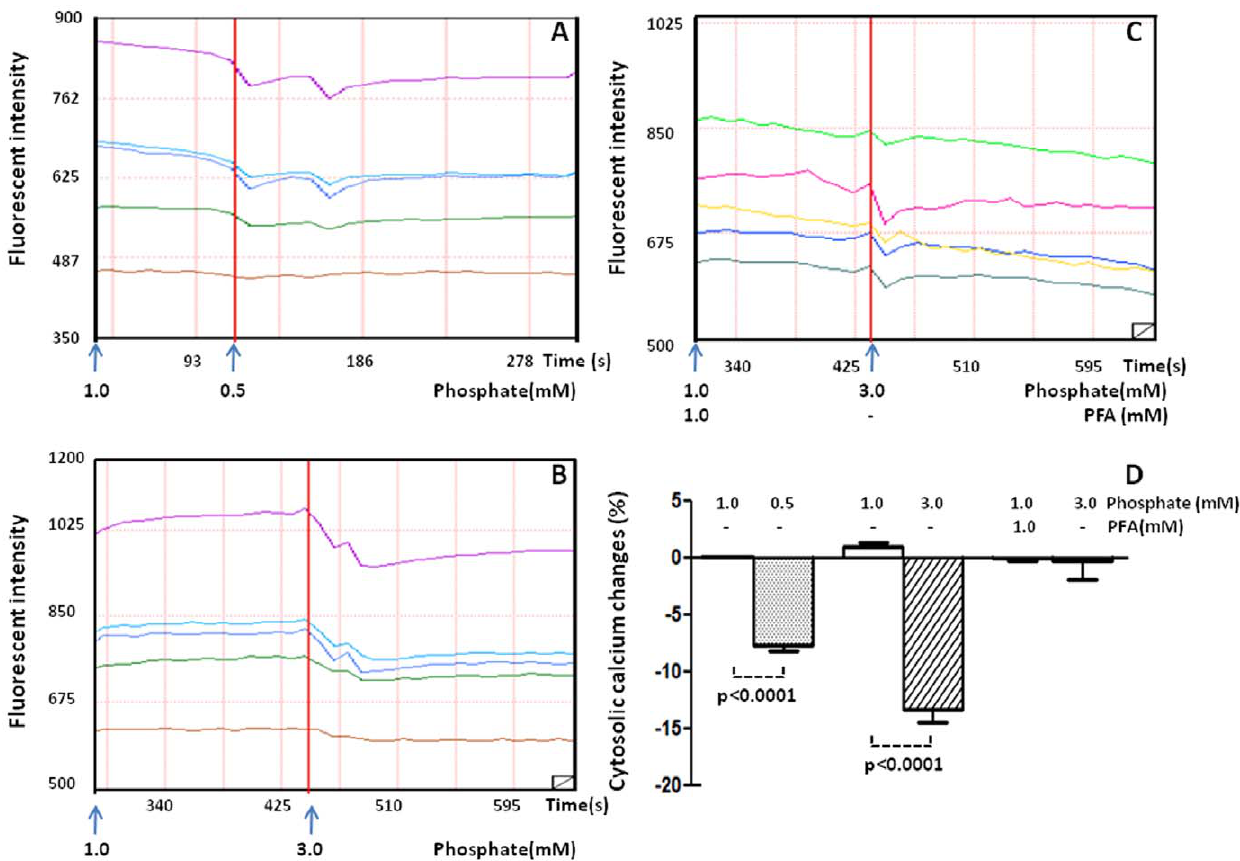
Figure 8. Effect of phosphate on intracellular calcium. The changes of fluorescence intensity was recorded in endothelial cells treated with 0.5 mM phosphate (A), 1 mM phosphate (B) and PFA + 3 mM phosphate (C). Percentage changes in intracellular fluorescent intensity is illustrated